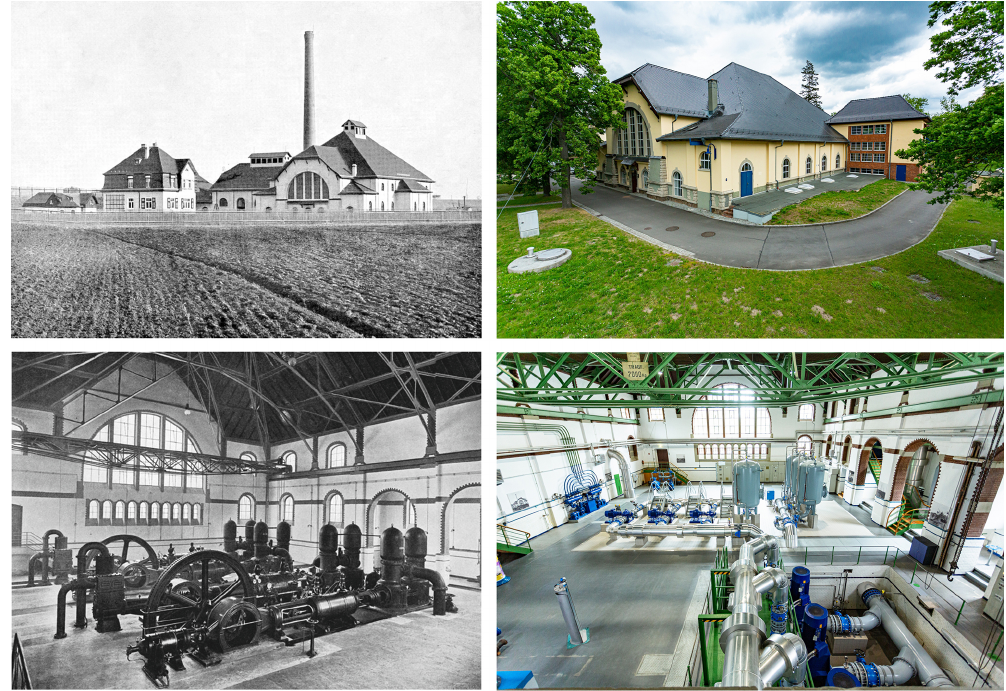
Figure 14. Buildings and pumps of the Canitz waterworks then and now, in Leipzig. On the left are the original buildings, as planned and designed by Adolf and Günther Thiem, around 1912. On the right are pictures of how they look today (photos: Leipziger Gruppe, with